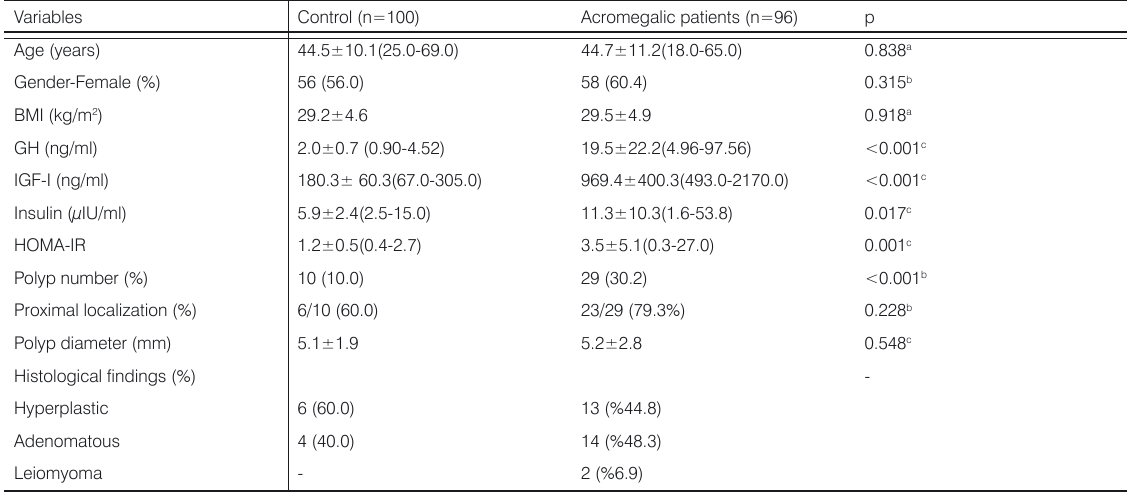
a Student’s t test. b Pearson Chi-square